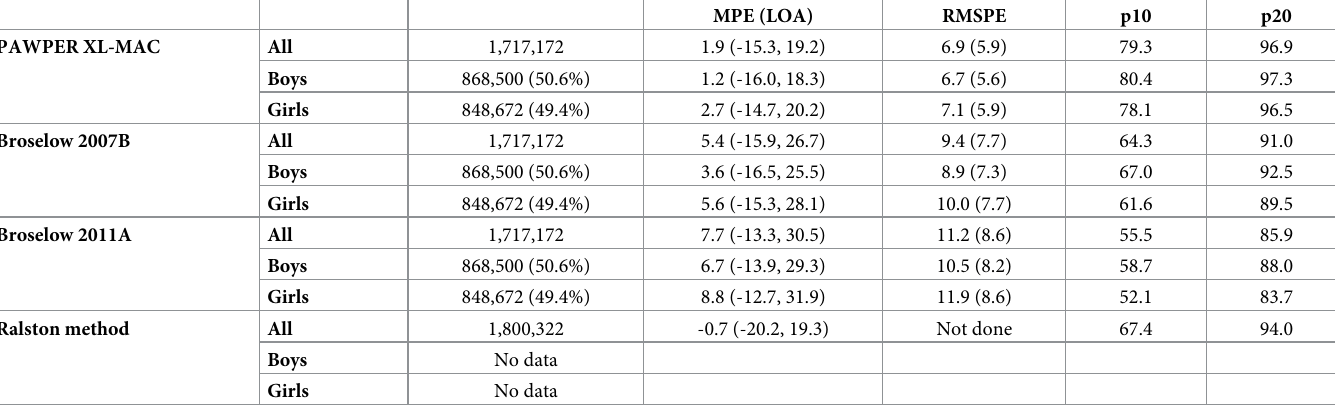
Table 3. Weight estimation performance by subgroups of